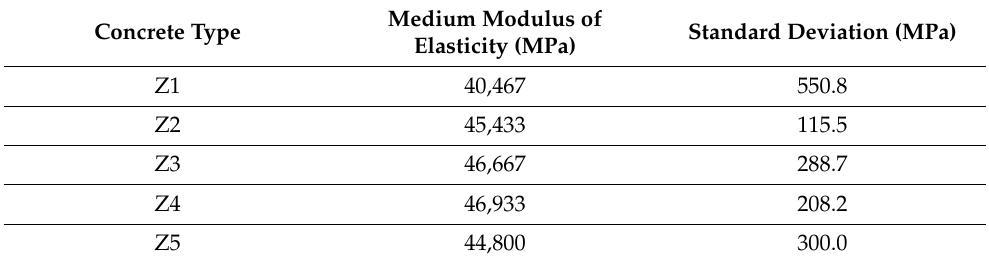
Table 9. Results of the resonance test of the modulus of elasticity.